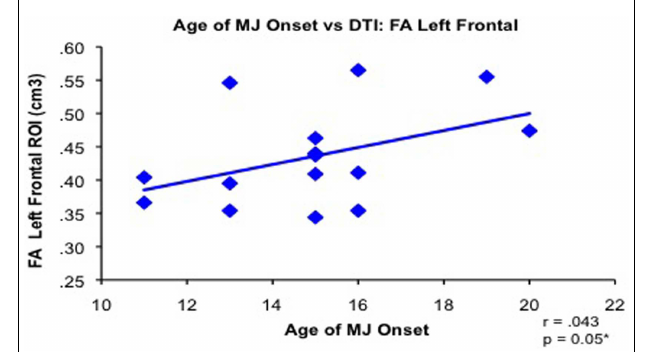
FIGURE 6 |Whole brain inhibitory processing results demonstrating significant differences between adolescent early onset ( n = 9) and late adult onset ( n = 14) MJ users, early onset MJ users demonstrated increased middle right cingulum and decreased anterior cingulate BOLD response to an inhibitory processing (multisource interference task, MSIT) fMRI task (adapted from Gruber et al., 2012)